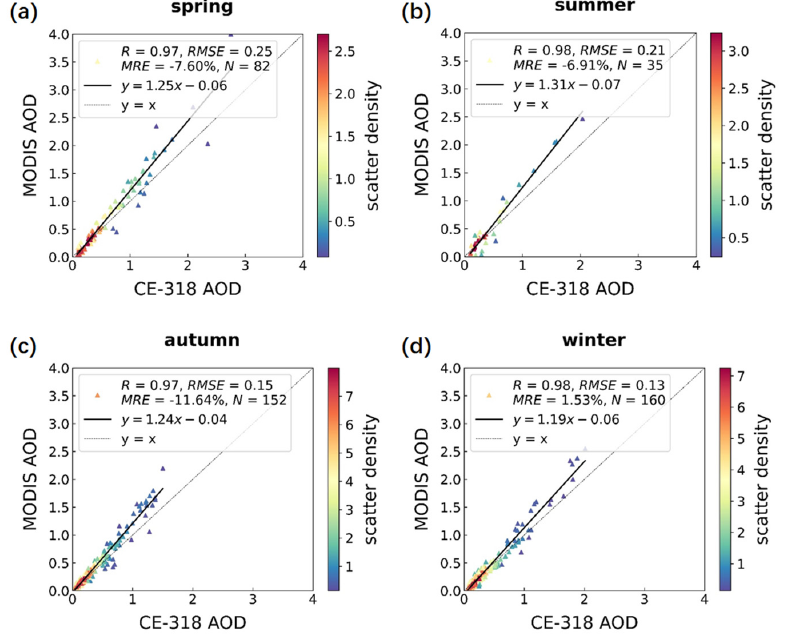
Figure 7. MODIS AOD inversions were evaluated for the different seasons of spring ( a ), summer ( b ), fall ( c ), and winter ( d ) during the August 2017 to March 2019 period, using the Gucheng sun photometer AOD as a benchmark.